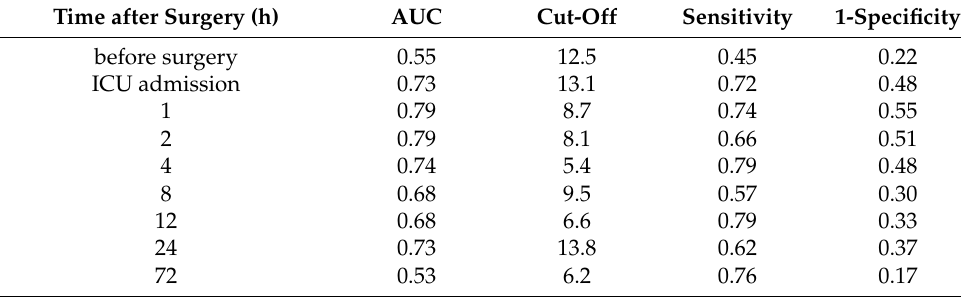
Table 5. Performance of urinary NGAL in AKI